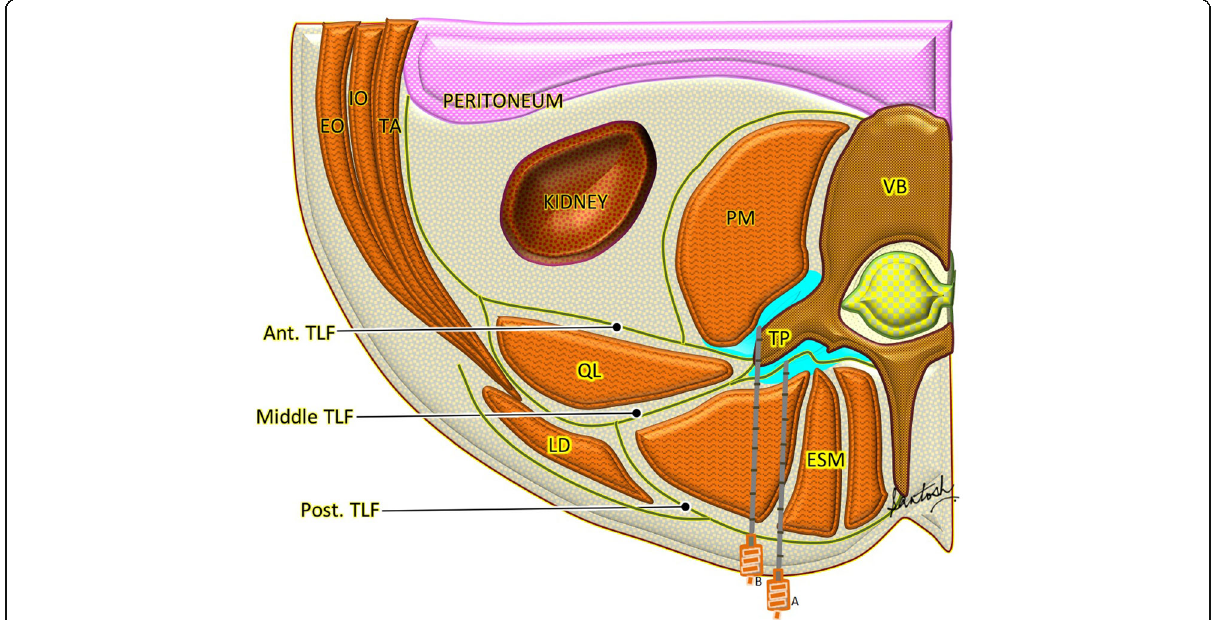
Fig. 2 Schematic diagram showing the variable catheter tip/needle position. A Needle on the transverse process. B Needle on the lower border of transverse process which may lead to the LA spread along the psoas muscle towards LP. EO — external oblique, ESM — erector spinae muscle, IO — internal oblique, LD — latissimus dorsi, PM — psoas muscle, QL — quadratus lumborum, TA — transversus abdominis. TLF — thoraco lumbar fascia, TP — transverse process, VB — vertebral